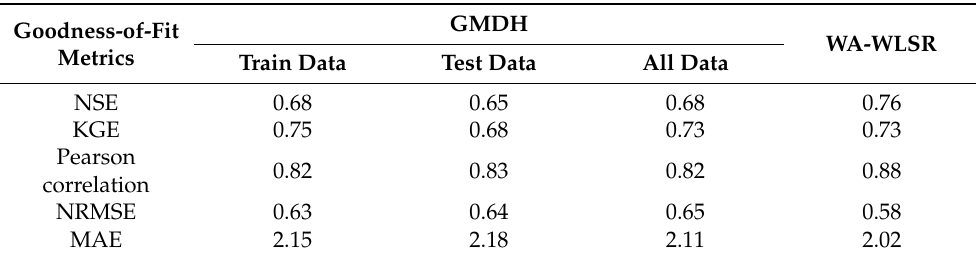
Table 10. The results of multi-model ensemble systems using the GMDH and WA-WLSR models. Goodness-of-Fit